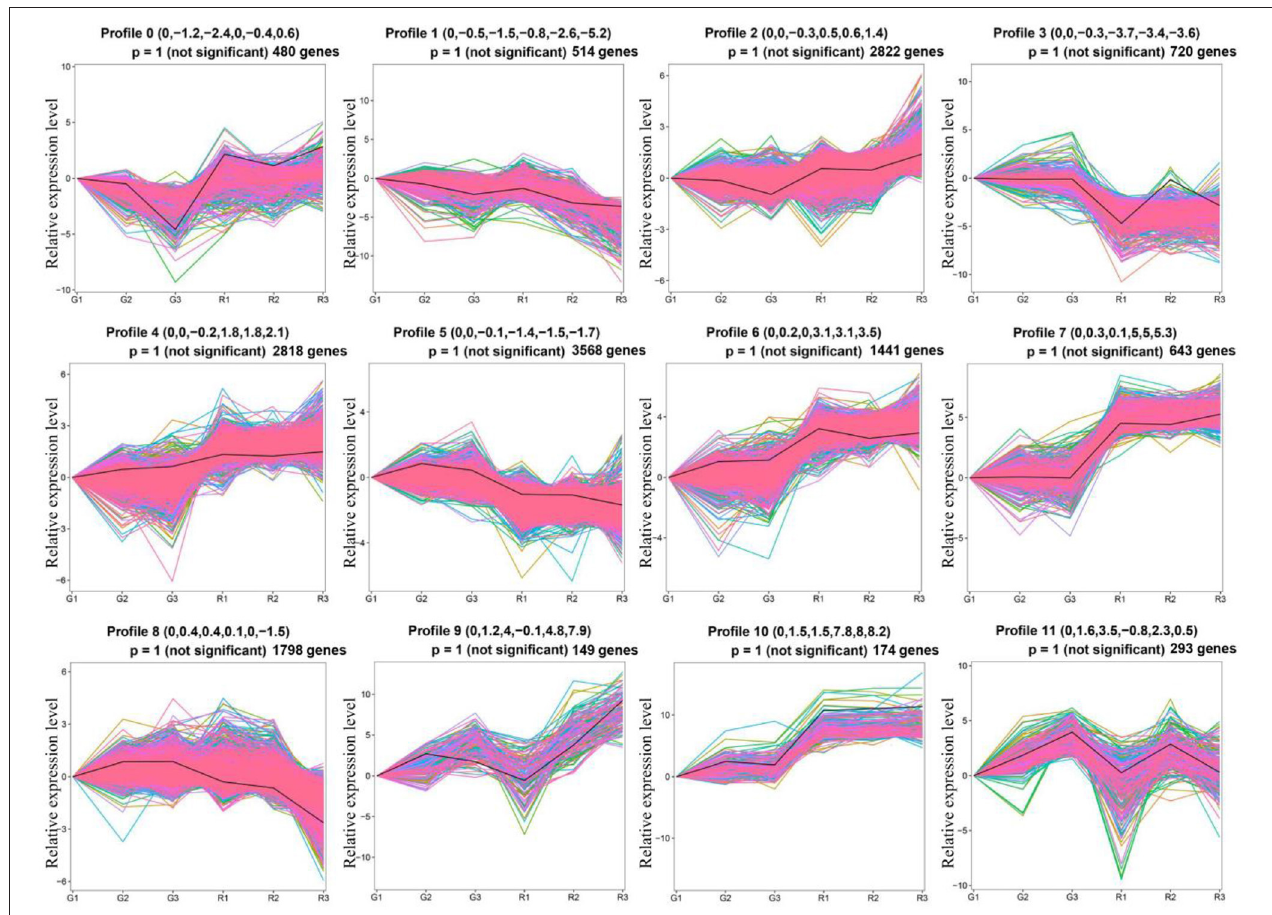
FIGURE 3 | Trend analysis of differentially expressed genes in different growth periods of red and green prickly ash